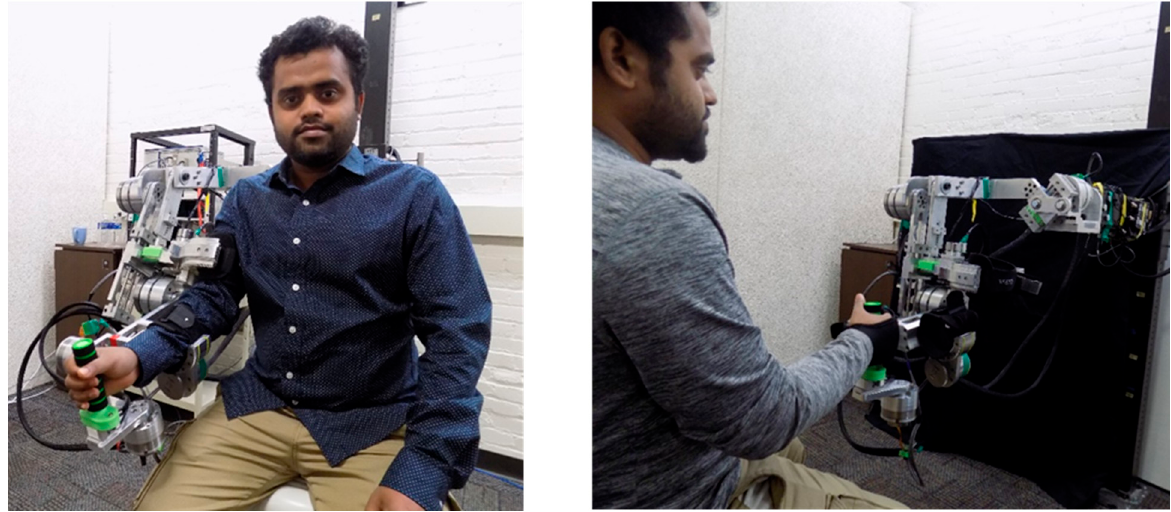
Figure 17. On the left , the subject is wearing u-Rob as an exoskeleton-type setup for joint-based exercises, whereas on the right , the subject is wearing u-Rob as an end-effector-type setup for end-point exercises.